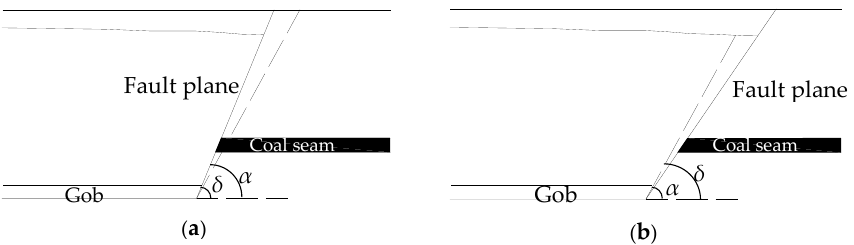
Figure 2. Fault effect towards mining subsidence. ( a ) The faults dip α is larger than the angle of critical deformation δ . ( b ) The angle of critical deformation δ is larger than the faults dip α .